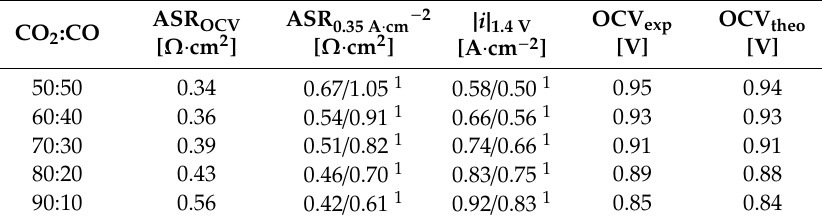
Table A1. ASR, | i | 1.4 V and OCV for various ratios of CO 2 :CO at 800 ◦ C.